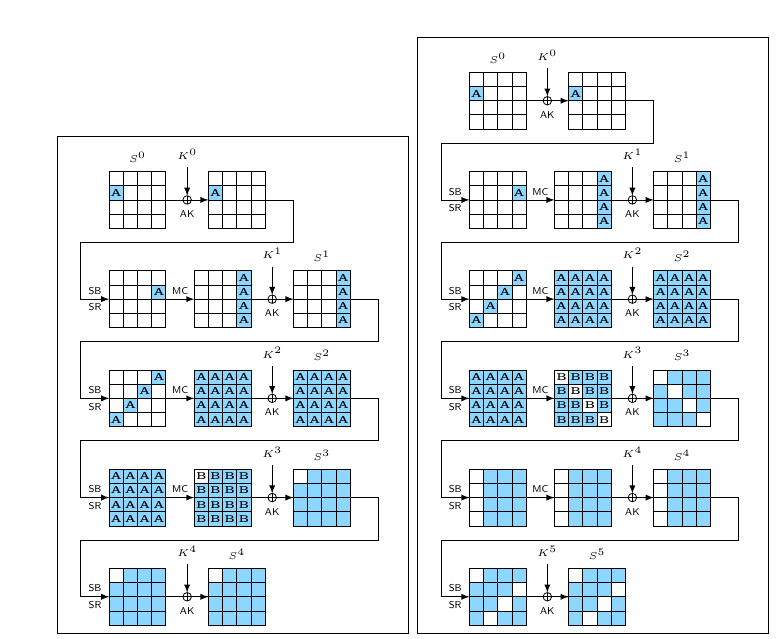
Figure 1: Our distinguishers over four ( left ) and five ( right ) rounds of AES . Darkened cells represent bytes with active (non-zero) difference, white cells represent bytes with zero